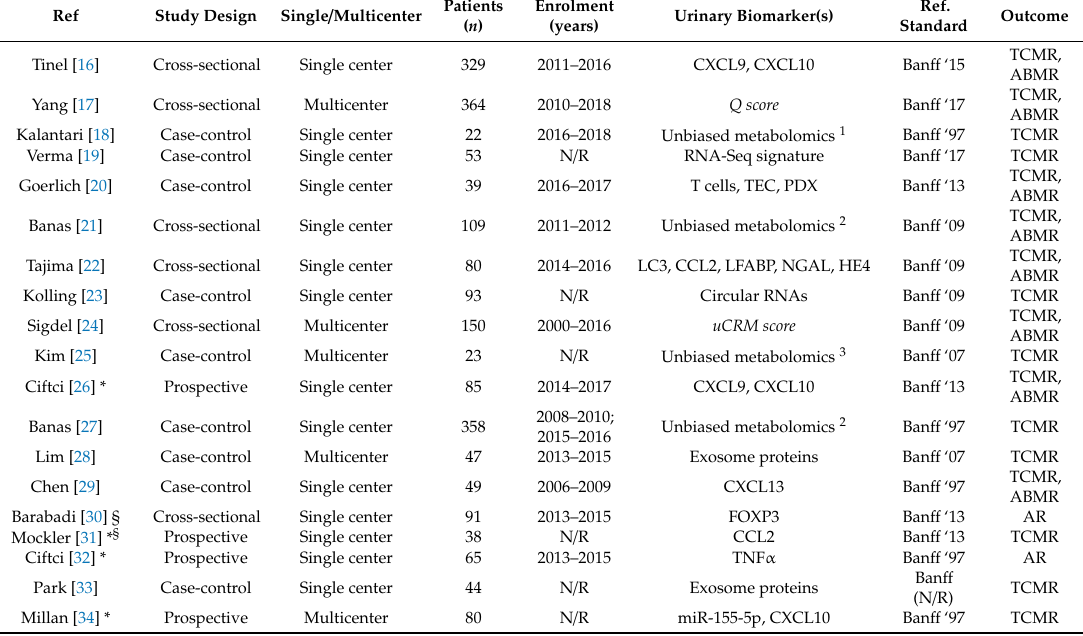
Table 1. Description of the study characteristics. The table summarizes the main characteristics of the 38 included